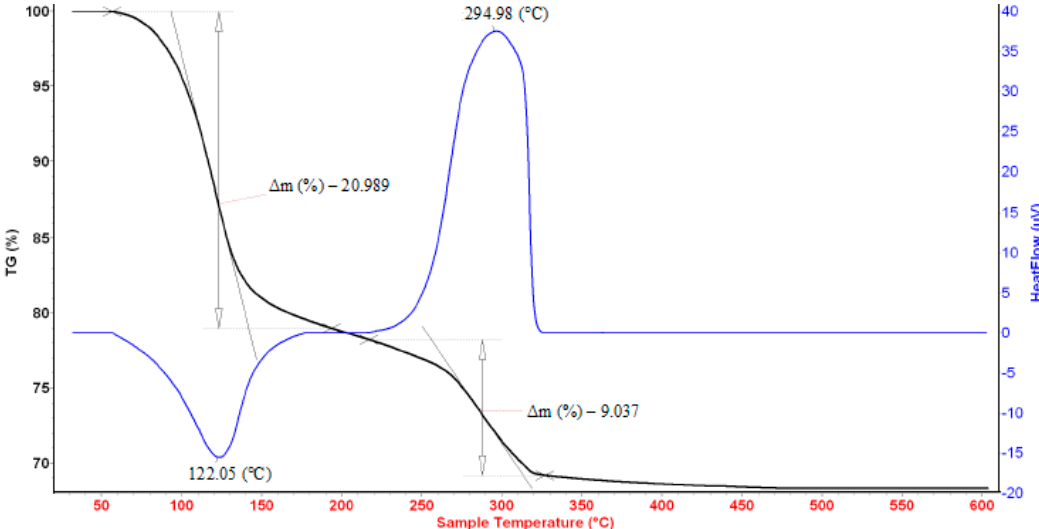
Figure 1. Thermo-gravimetric analysis/differential scanning calorimetry (TGA/DSC) results of the precipitate containing Fe (III).